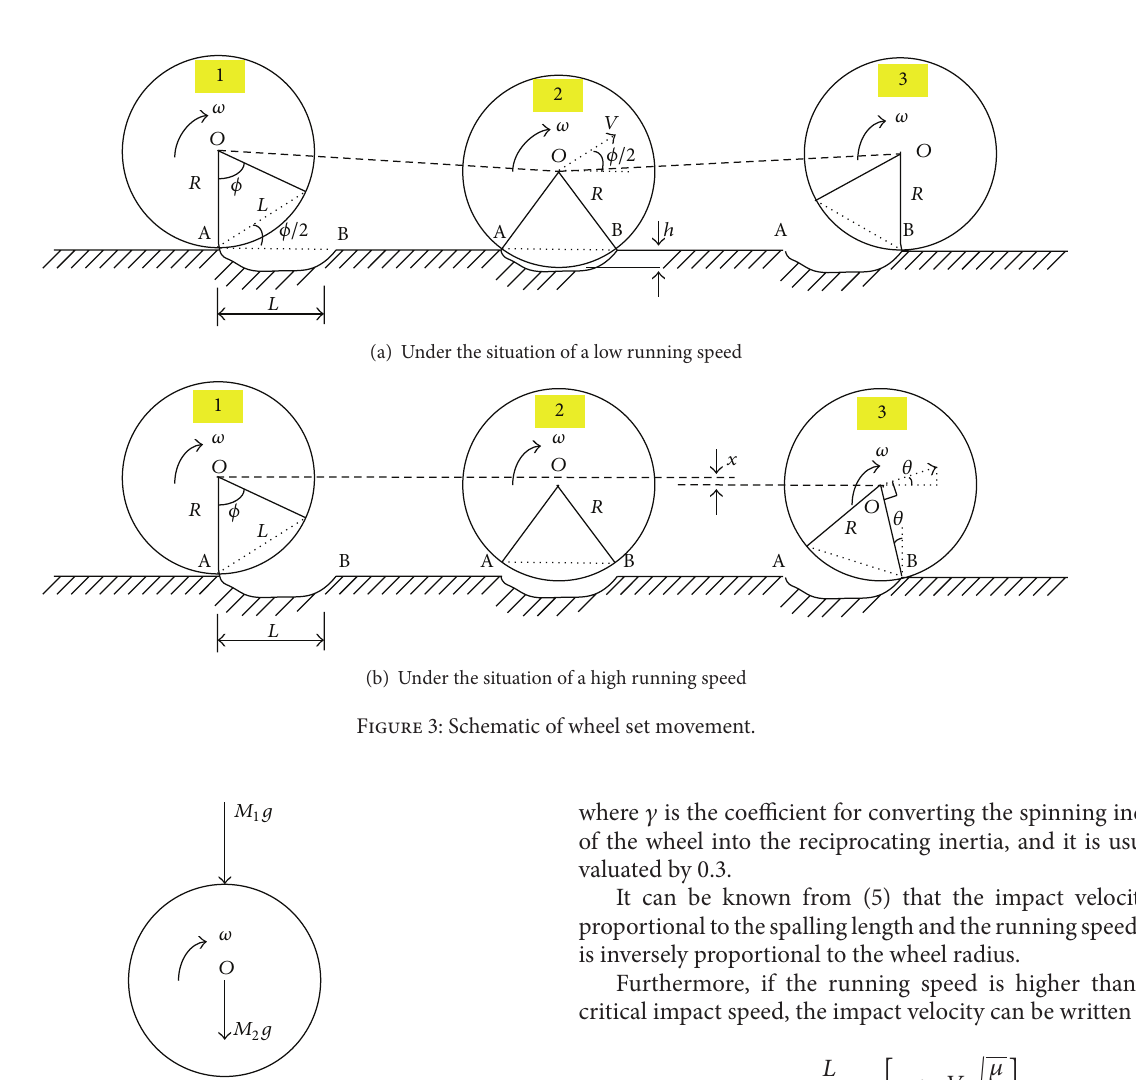
Figure 4: The loading condition of the wheel set.